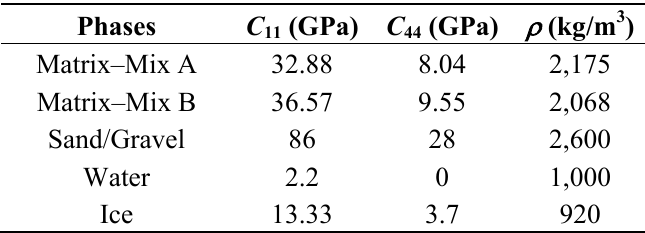
Table 1. Properties of constituent’s